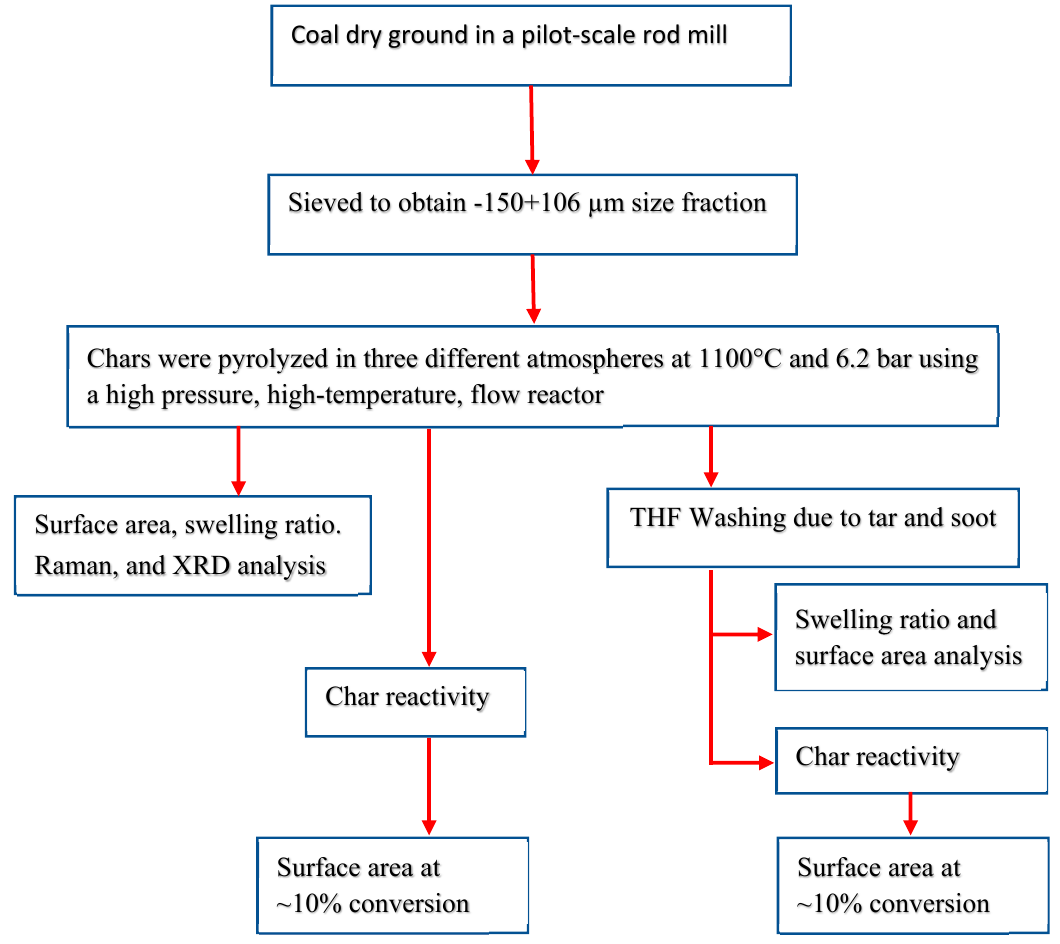
Figure 2. Methodology employed in this investigation. Figure 2 . Methodology employed in this investigation.